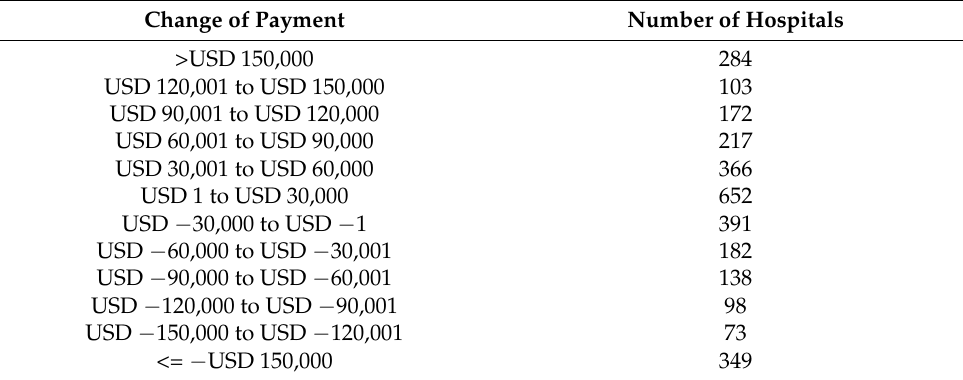
Table 2. Distribution of change of payments for FY 2016.